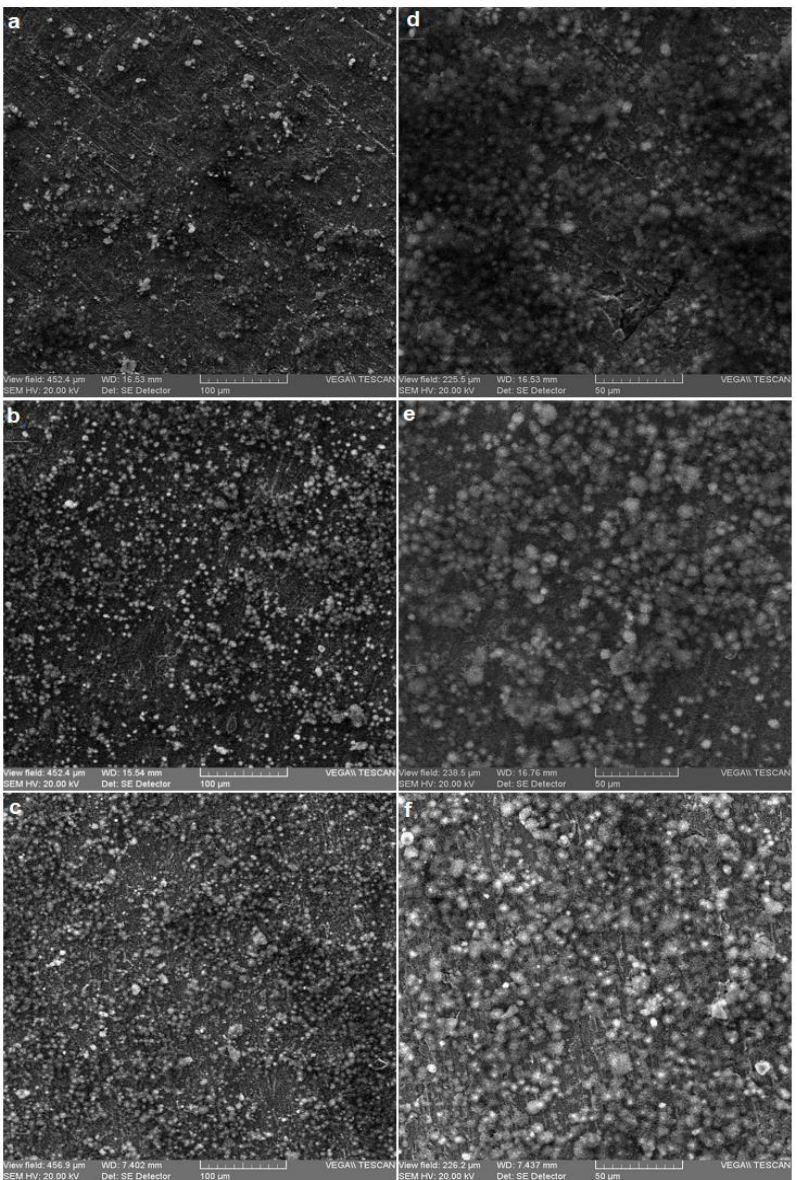
Figure 2. Structural aspects of the surface of coated samples at 500×: ( a ) S1-HA; ( b ) S2-HA; ( c ) S3- HA; and 1000×: ( d ) S1-HA; ( e ) S2-HA; ( f ) S3-HA. and 1000 × : ( d ) S1-HA; ( e ) S2-HA; ( f )